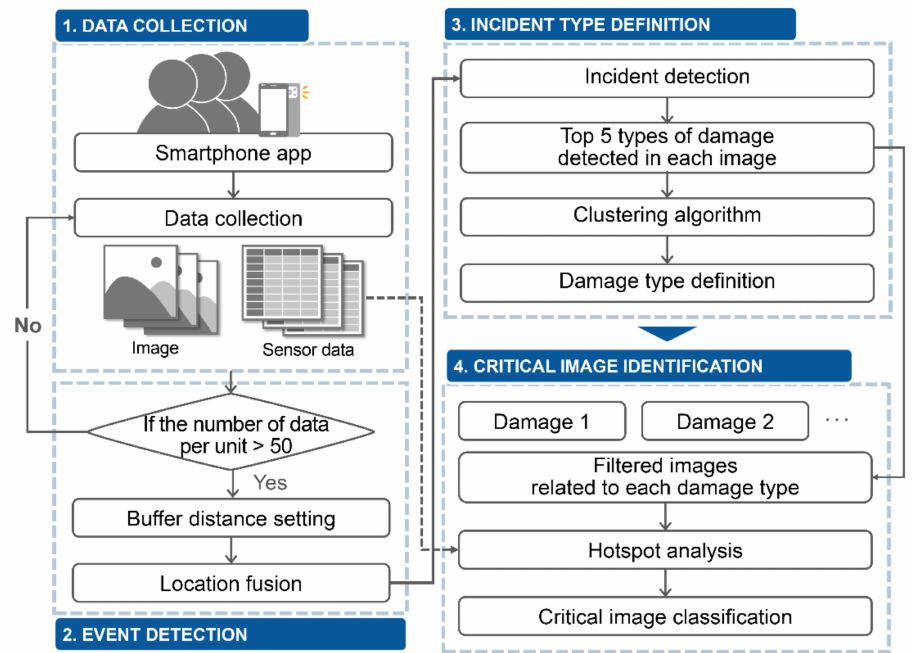
Figure 1. Schematic process for automatic data collection and situation